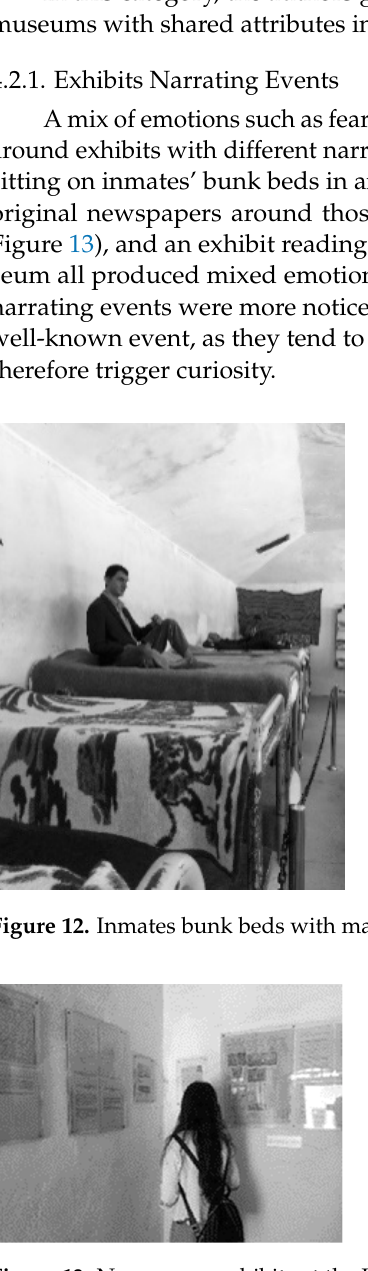
Figure 13. Newspaper exhibits at the Ulucanlar